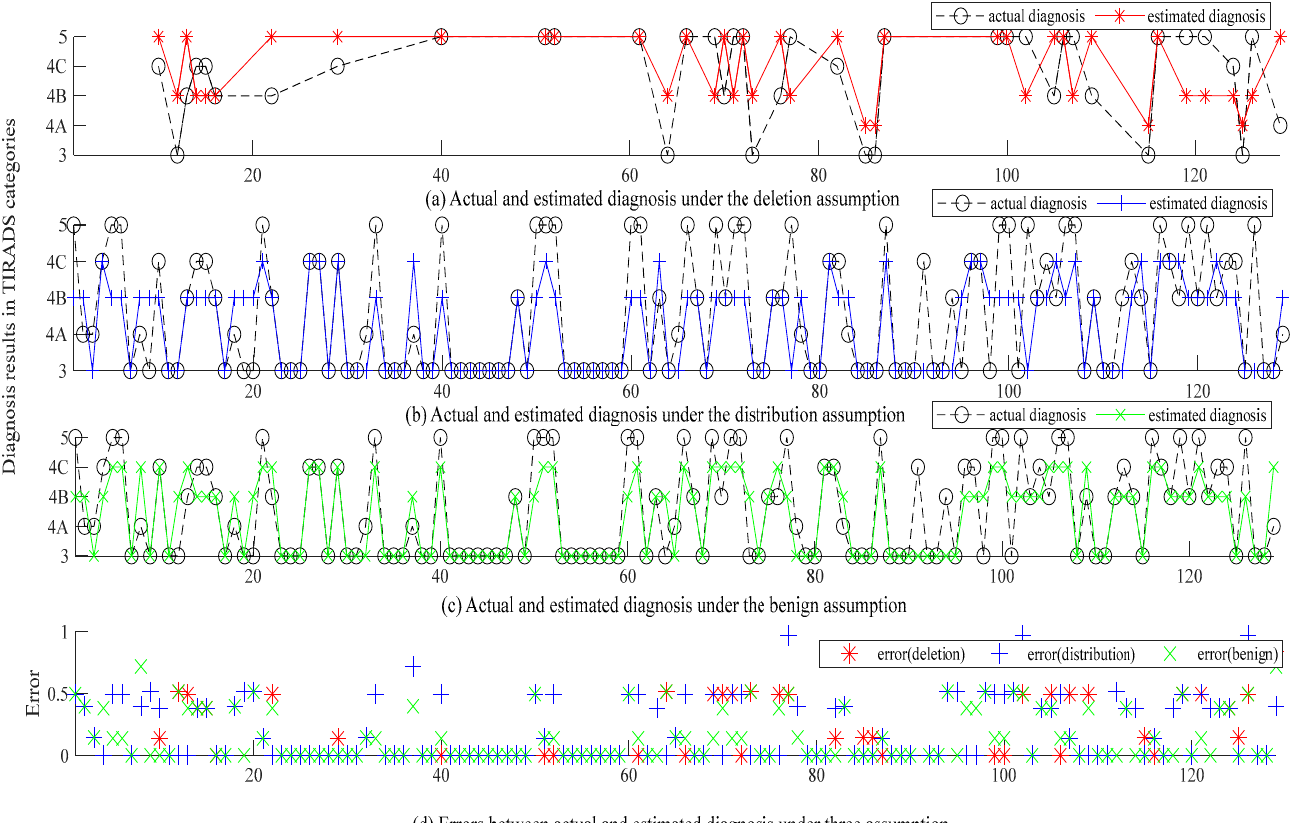
Figure 5. Actual output, estimated output, and error of Doctor No. 3 under three assumptions.